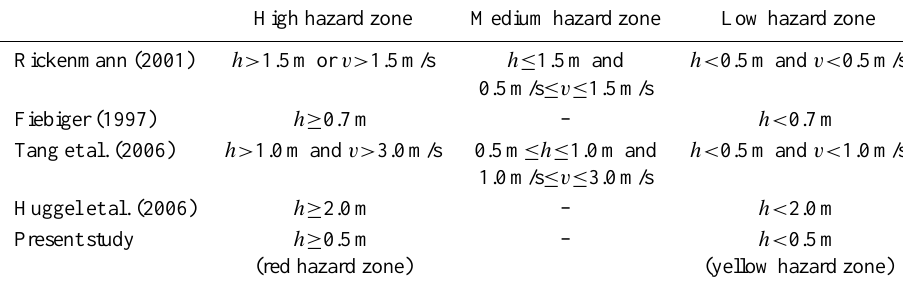
Table 1. Delineation criteria of hazard zones for debris